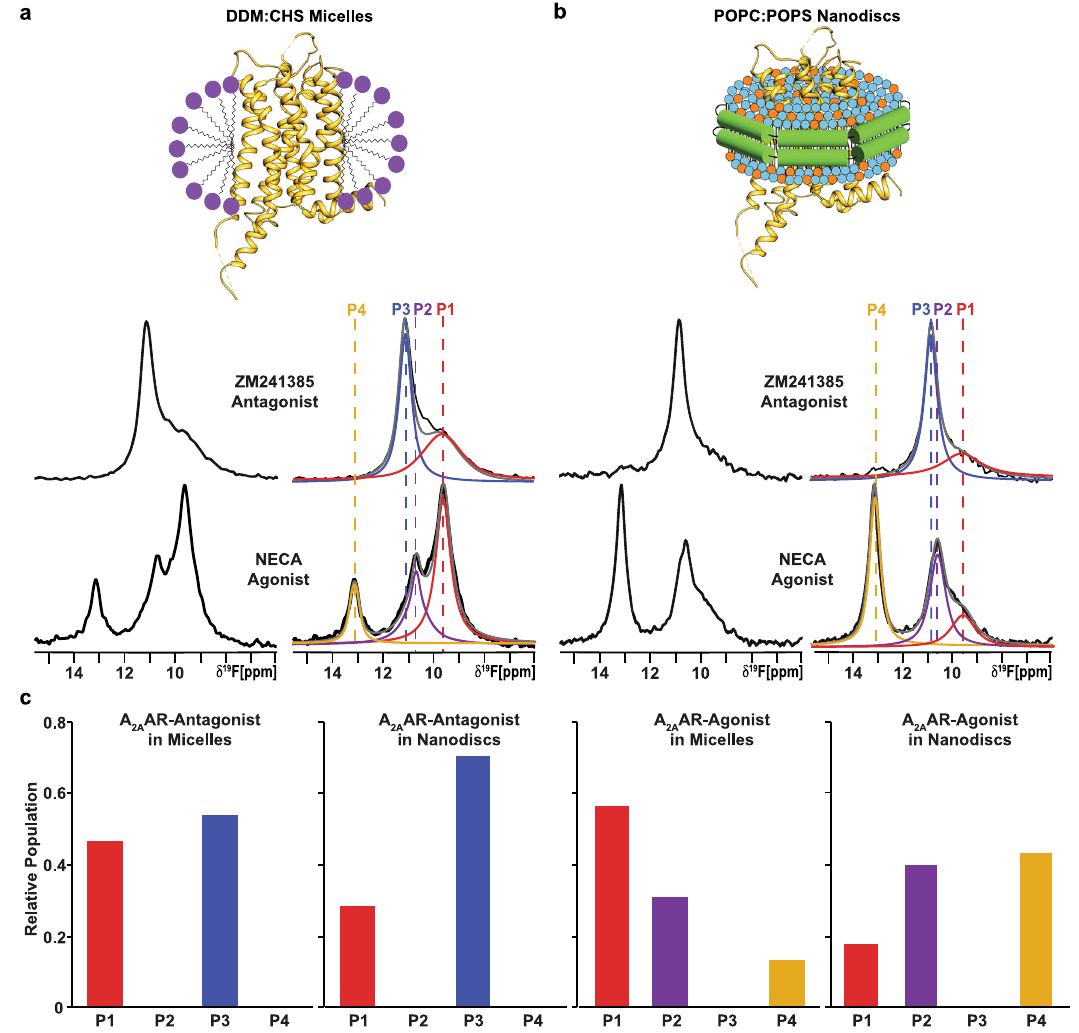
Fig. 1 | NMR-observed conformational states of A 2A AR-ligand complexes com- paredintwodifferentmembranemimetics.a The1-dimensional 19 F-NMRspectra of A 2A AR[A289C TET ]reconstituted intoDDM/CHSmixedmicellesand incomplexes with the antagonist ZM241385 and agonist NECA. On the right, the NMR spectra shown on the left are interpreted by Lorenztian deconvolutions with the minimal number of components that provided a good fi t, labeled P1 to P4. The chemical